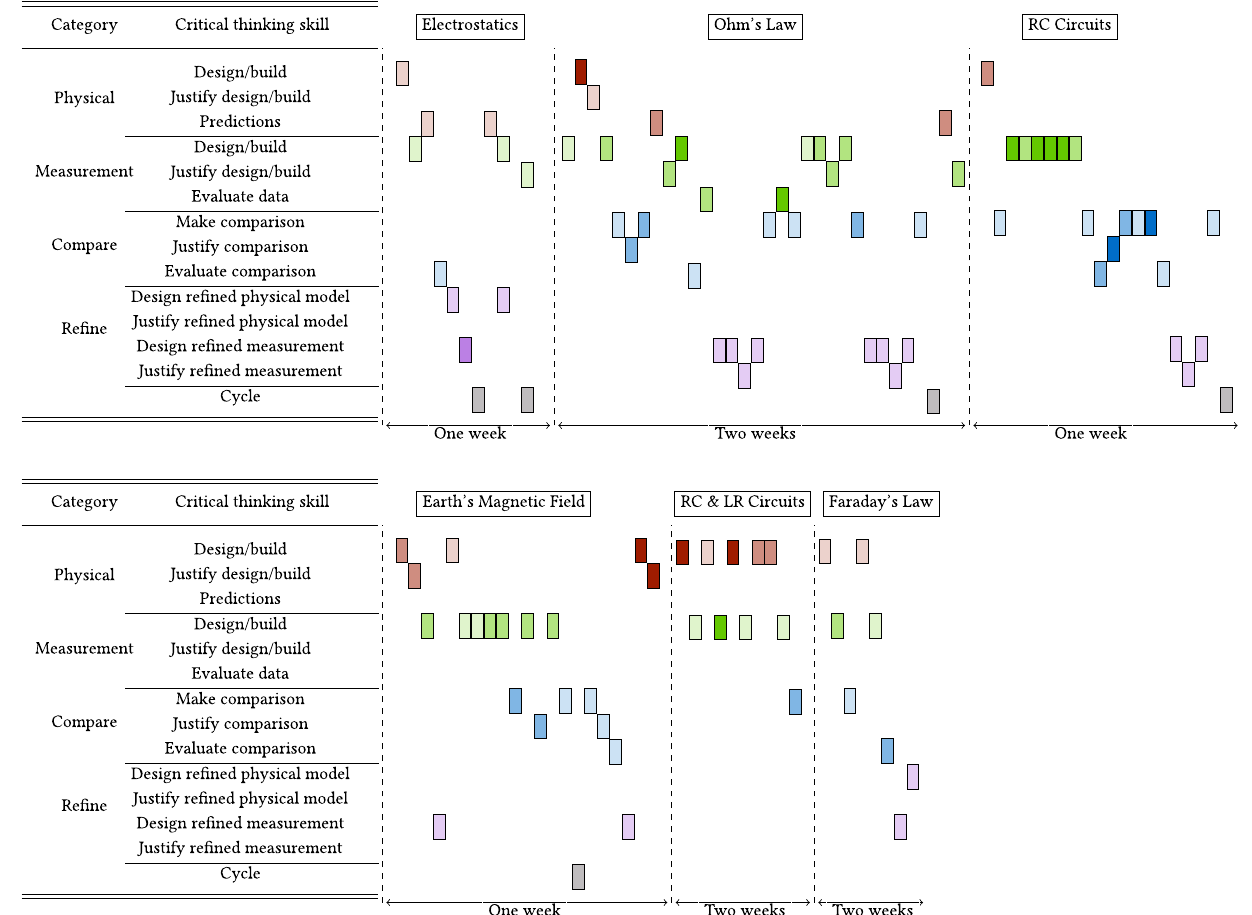
shade).FIG. 5. Codes applied to semester 1 lab instructions ordered by the appearance of the code in the lab instructions, and lab activities are sequentially ordered. Colors correspond to the category of the code and shade provides the level of agency (less available agency identified by a darker